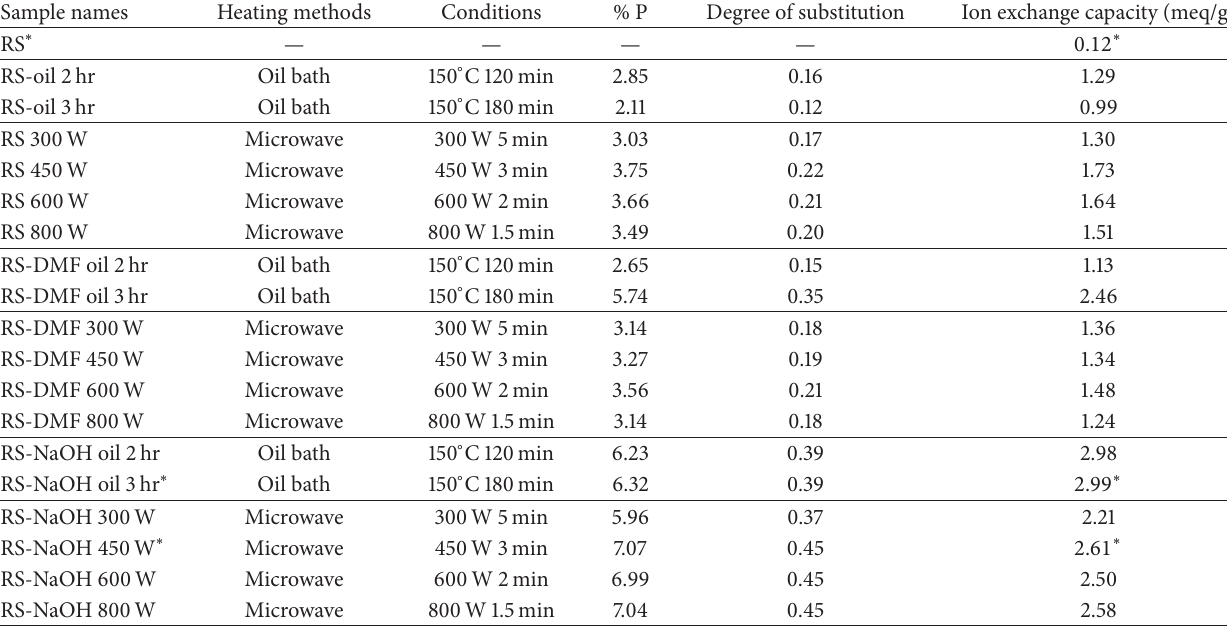
Table 2: Reaction conditions for preparations of modified rice straw, phosphorus content, degree of substitution, and ion exchange capacity of the modified rice straw.